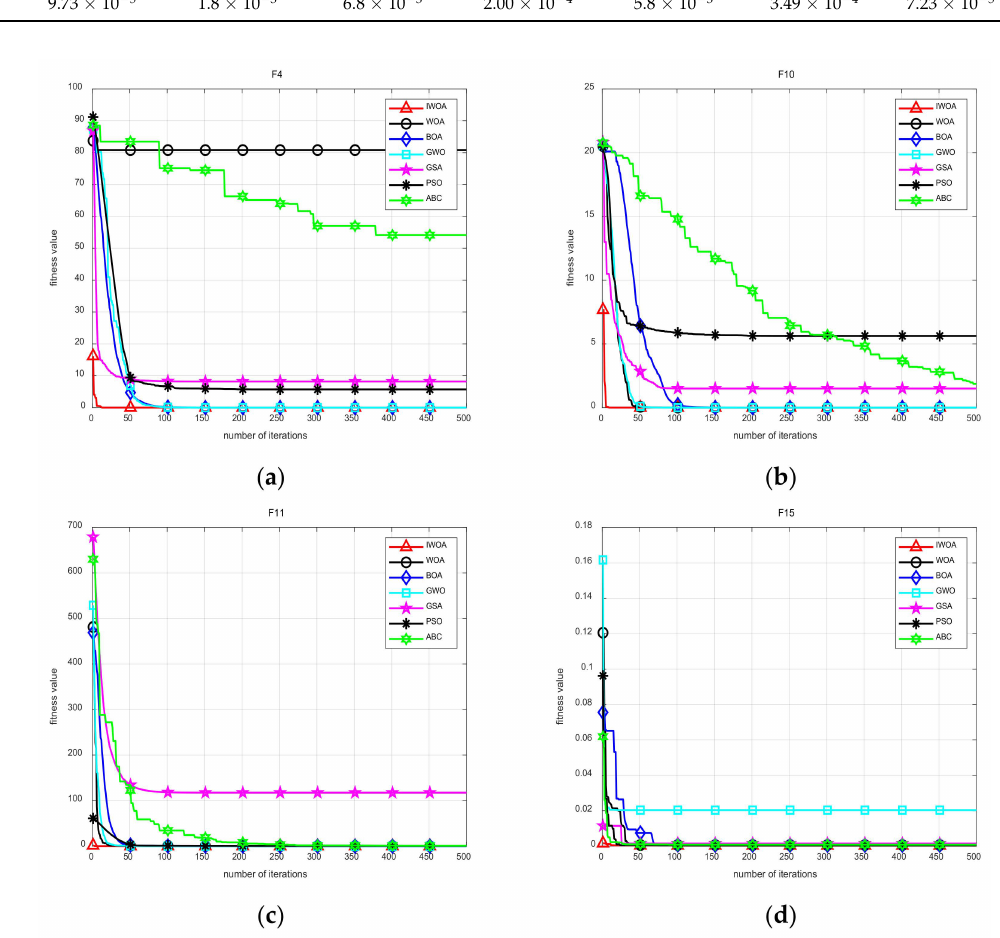
Figure 3. Algorithm convergence curve: ( a ) test function F 4 , ( b ) test function F 10 , ( c ) test function F 11 , ( d ) test function F 15